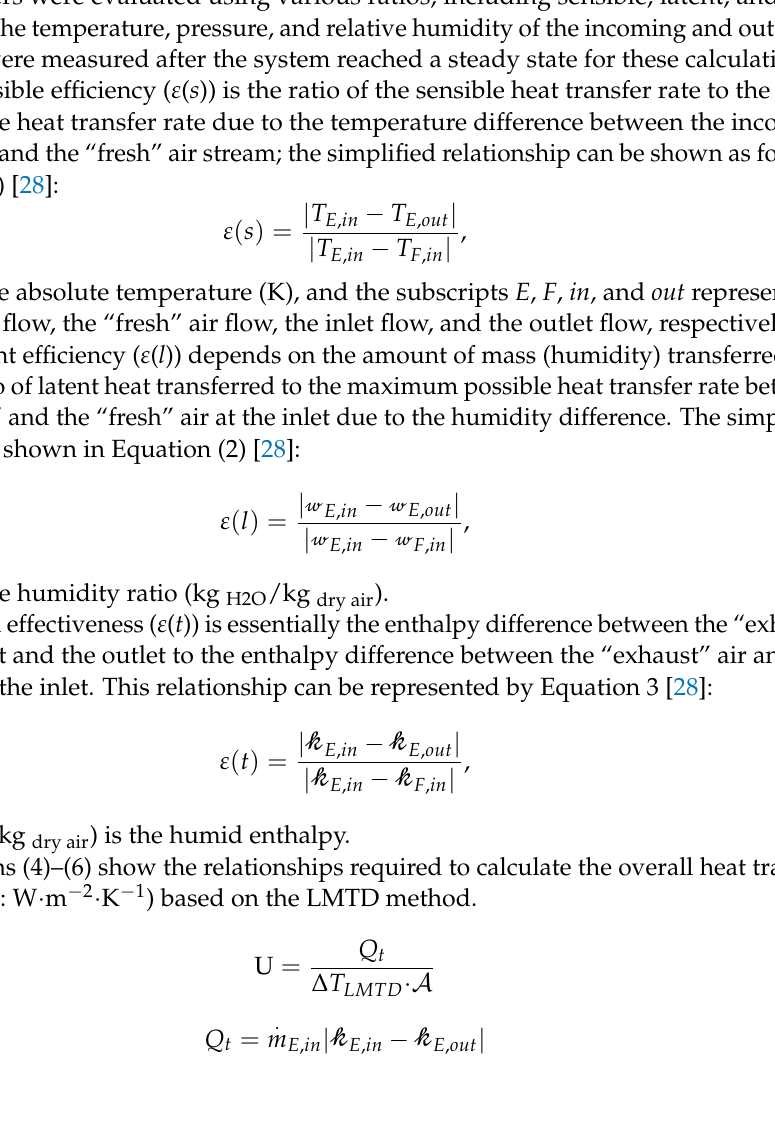
Figure 3. FESEM micrographs of the cross-section of ( a ) kraft paper, ( b ) P-MEM, and ( c ) C-MEM.